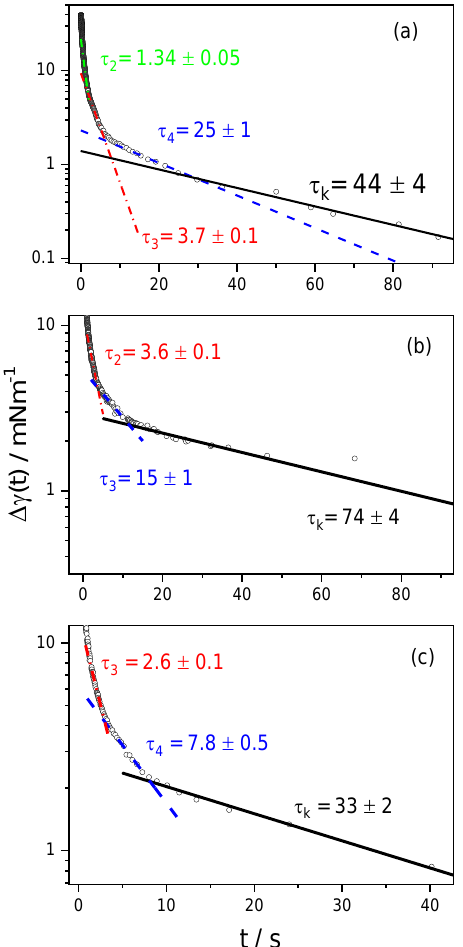
Figure 10. Several relaxation times following an exponential decay at concentrations above the cmc. Table 3. Average ( ψ ), the equilibrium surface ( ψ 0 ) and subsurface ( ψ a ) electrostatic potentials from Equations (6) and (7). ψ a is calculated as 2 ψ − ψ 0 = ψ a . c s / mM e ψ / k B